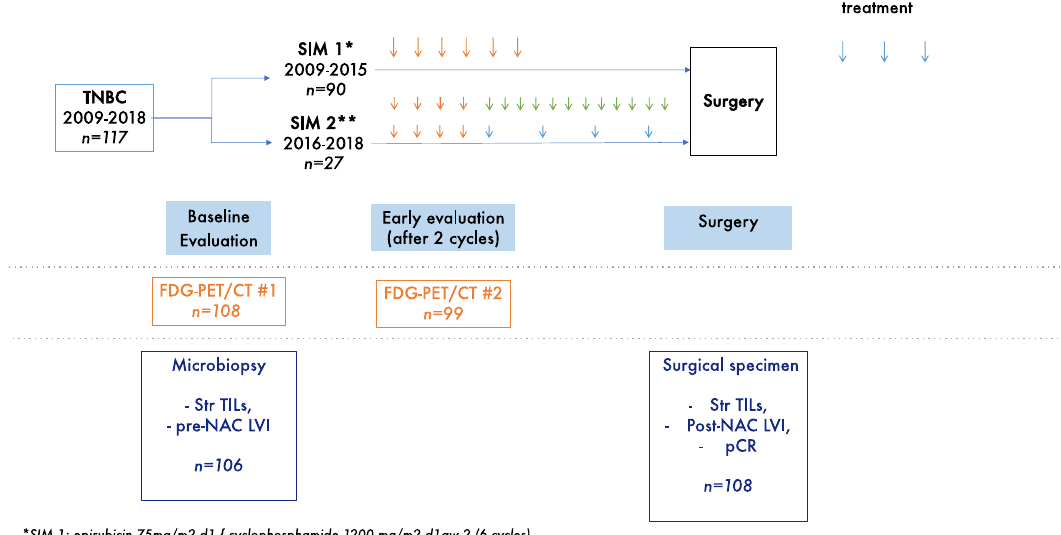
Figure 1. Study diagram. Orange arrows represent dose dense dose intense anthracycline and cyclophosphamide-based chemotherapy; blue arrows represent taxanes based chemotherapy; green arrows represent weekly paclitaxel chemotherapy.